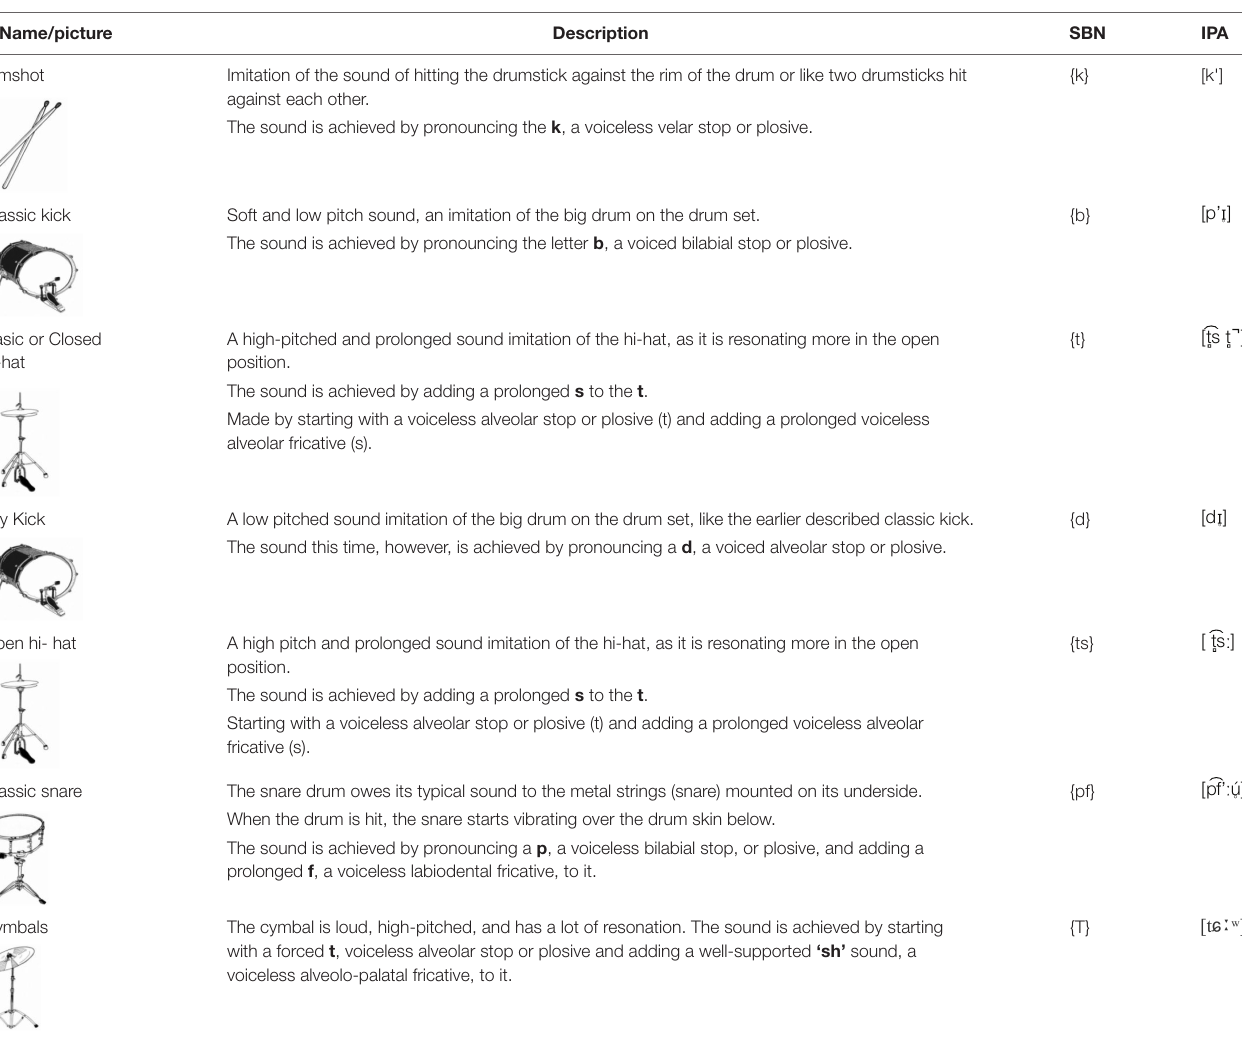
TABLE 1 | Musical classification and the phonetic description of the basic beatboxing sounds used during the workshops based on the description used in prior research (Proctor et al., 2013; IPA, 2015), the SBN (Splinter and TyTe, 2002) and the phonological description of consonants (O’Grady et al., 2017). Name/picture Description